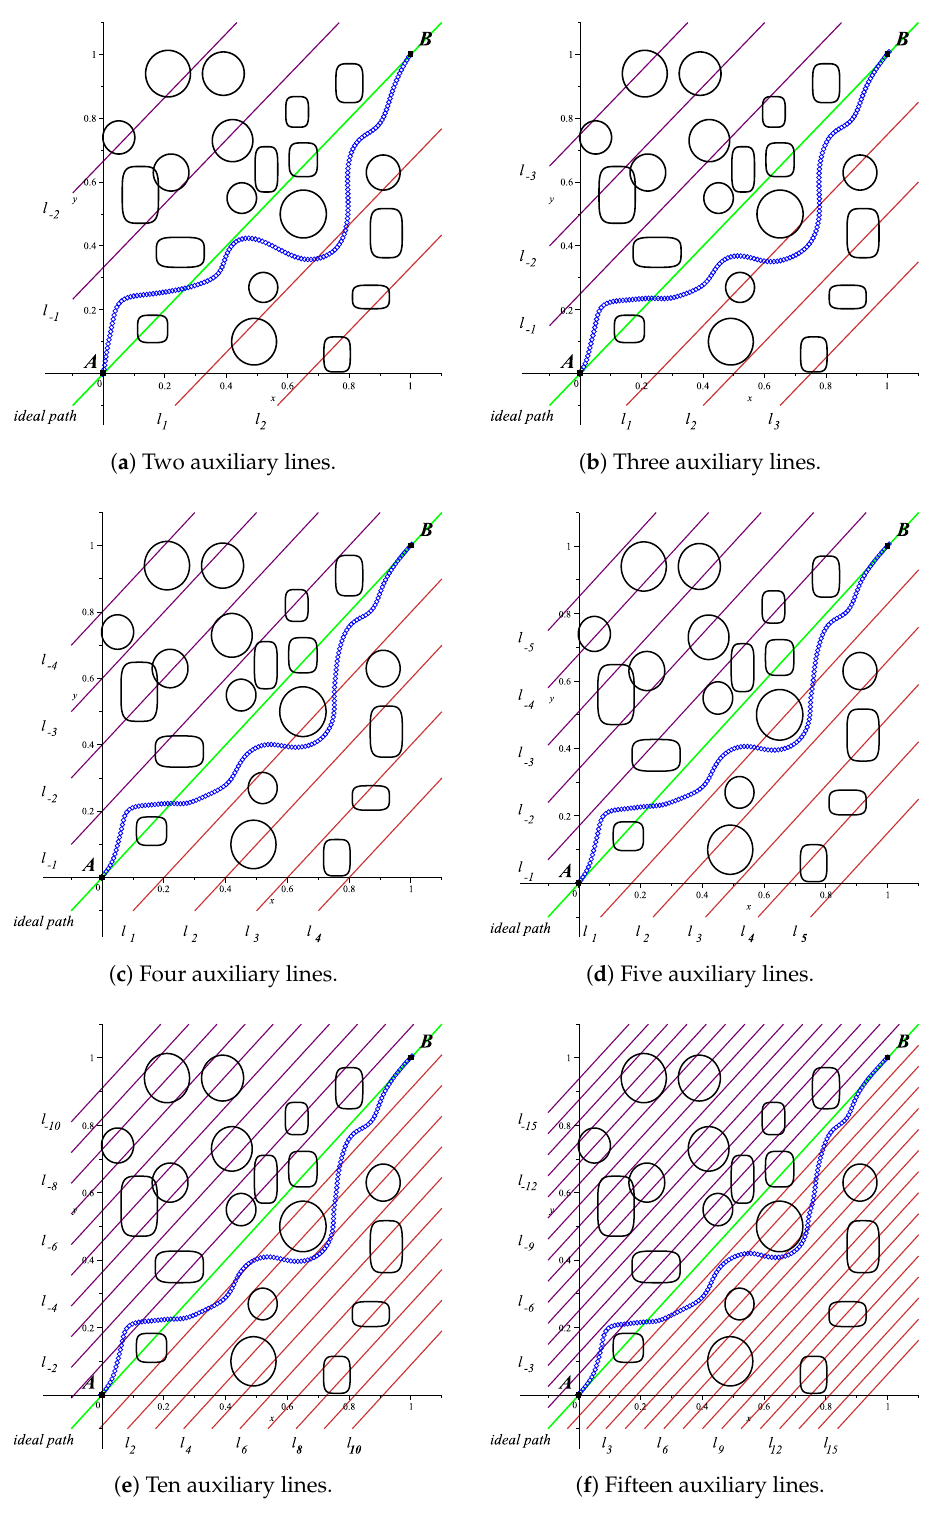
Figure 4. Analysis of auxiliary